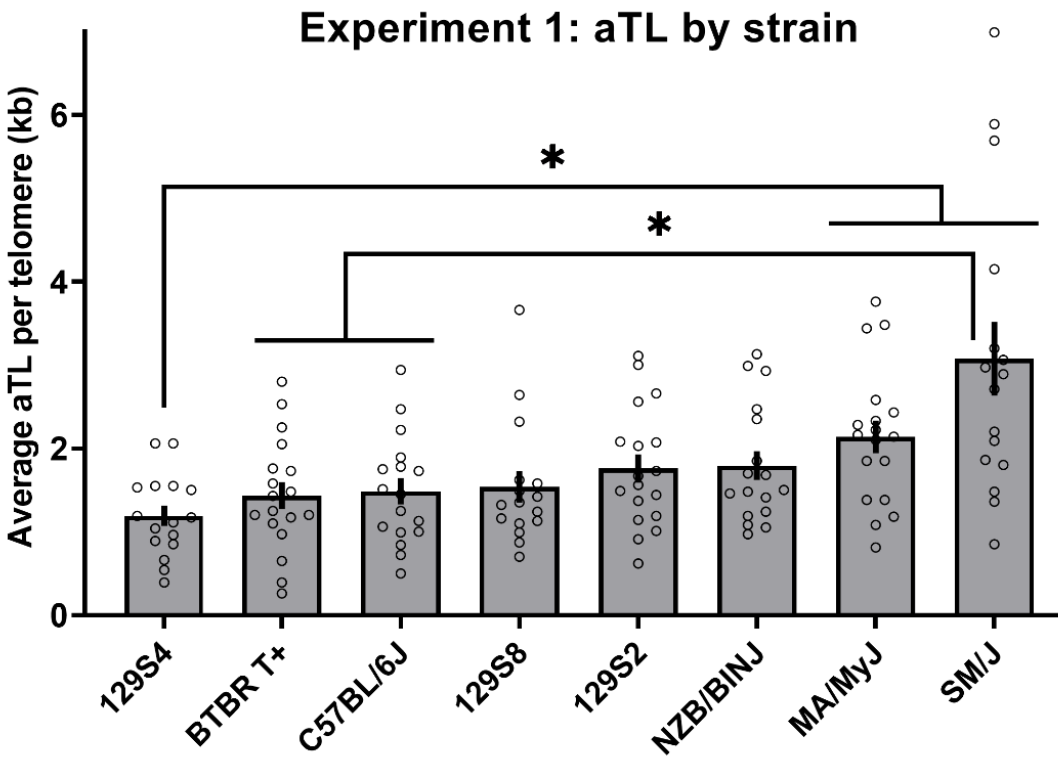
Figure 2. Average liver aTL per telomere (kb) in Experiment 1 inbred mouse strains. * Indicates significant strain differences at a Games–Howell corrected significance threshold of 0.05. Unfilled circles indicate individual datapoints per strain. n = 16–18 per strain.